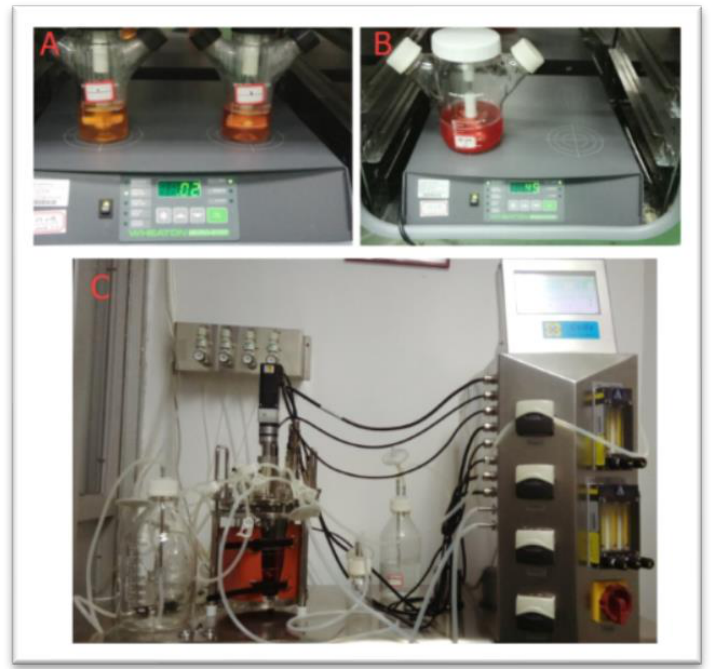
Figure 2. Different suspension culture systems. ( A ) The 125 mL stirring flask; ( B ) the 500 mL stirring flask; ( C ) the 3 L bioreactor.